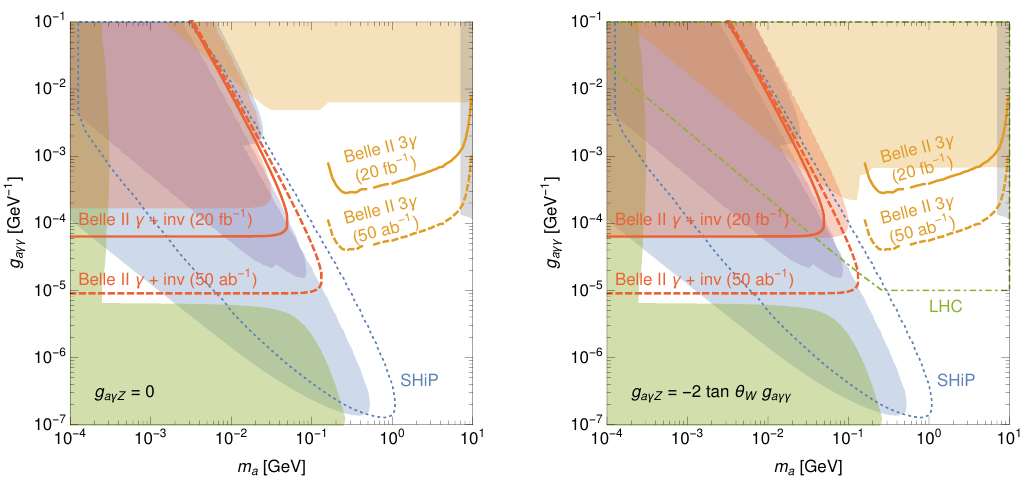
Figure 7 . Projected Belle II sensitivity (90 % CL) compared to existing constraints on ALPs with photon coupling (left) and hypercharge coupling (right), as well as the projected sensitivities from SHiP [22] and the LHC